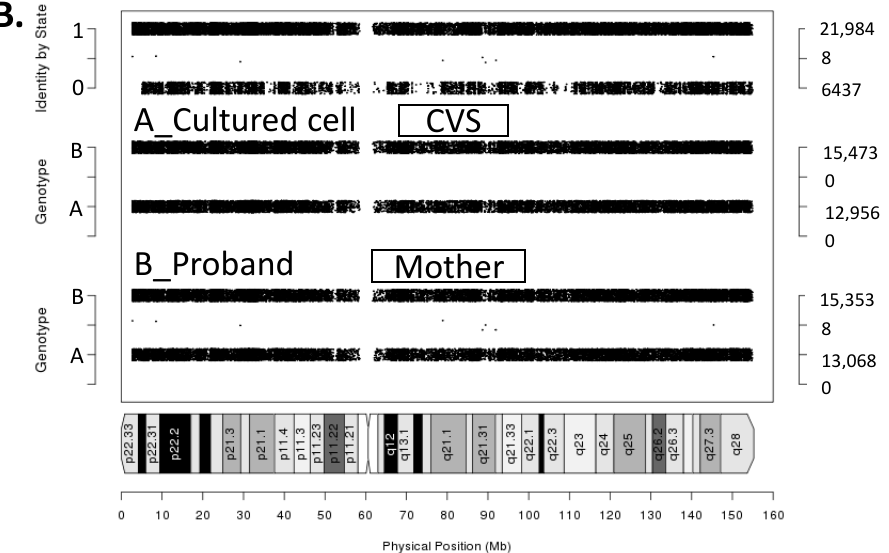
Figure 4. Linkage analysis using chromosomal microarray. ( A ) Single nucleotide polymorphisms (SNP) duo image for chromosome 1 showing identity by state (sharing one allele) for the whole chromosome. Whole genome comparison confirmed child-parent relationship. Note: Chromosome 1 SNPduo Output A_Culture CVS–B_Proband Mother Average Identity by State (IBS):1.84; ( B ) SNP duo for chromosome X between the foetus and the X0 cell line showing IBS0, that is sharing no alleles for most of the chromosome including the FMR1 gene. Note: Chromosome X SNPduo Output A_Cultured CVS–B_Proband Mother Average IBS:1.1.547.